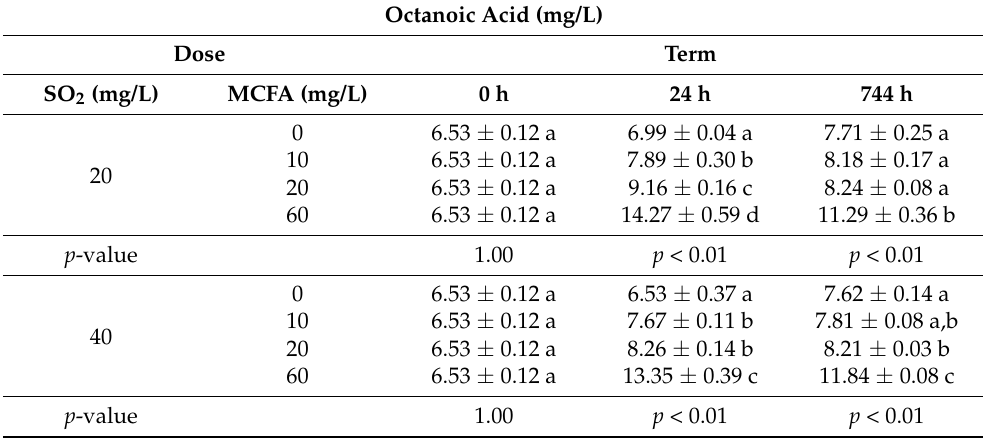
Table A1. Detailed results of octanoic acid, decanoic acid, dodecanoic acid, and fermentable sugars content. Data normality was verified by the Shapiro–Wilk test, followed by ANOVA analysis ( p -value). The average values ( n = 3) are supplemented by the contribution into homogeneous groups (a, b, c, d) according to Fisher’s LSD (least significant difference) test ( α =